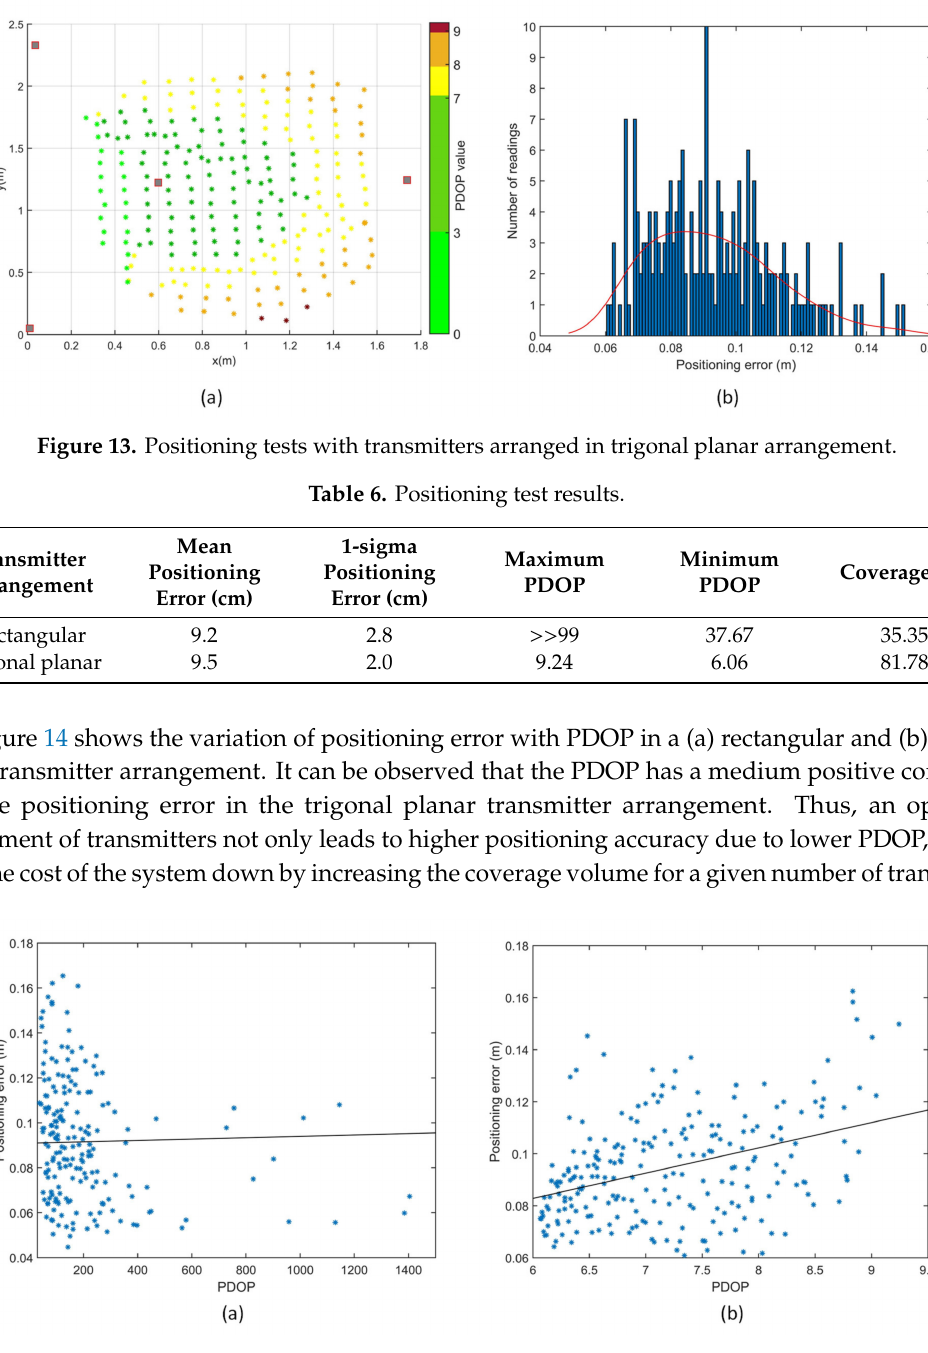
Figure 14. Variation of positioning error with PDOP ( a ) rectangular transmitter arrangement. ( b ) Trigonal planar transmitter